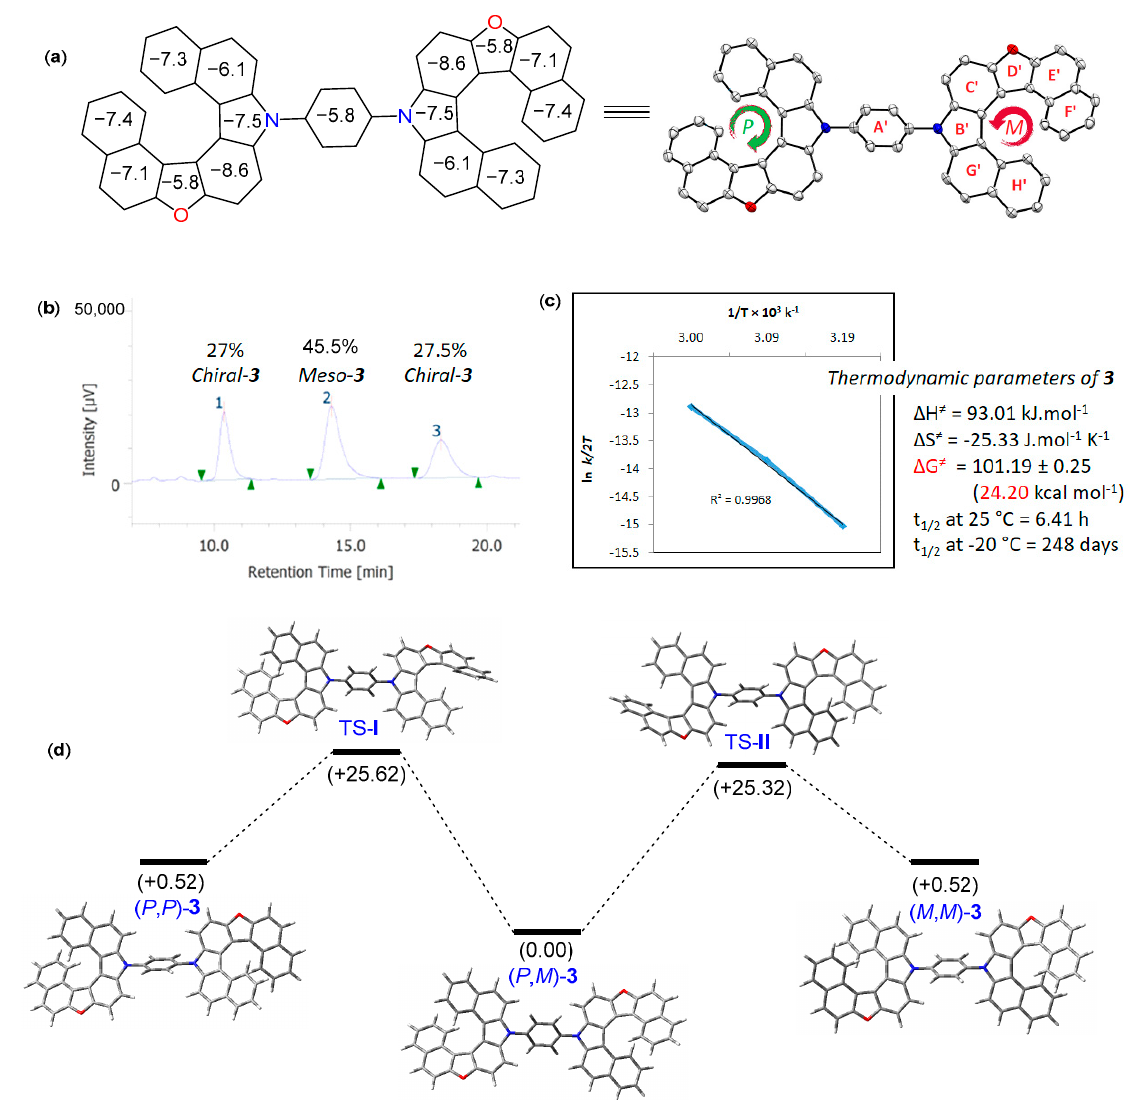
Figure 3. ( a ) NICS (0) values of ( P , M ) ‐ 3 calculated at the MN15/6 ‐ 311G+(2d,p) level; ( b ) HPLC chromatogram determined by (Daicel Chiralpak IA, n ‐ hexane/ i ‐ PrOH = 20/1, flow rate 1.0 mL/min, T = 25 ºC, 240 nm): t 1 = 10.36 min, t 2 = 14.30 min, and t 3 = 18.32 min; ( c ) Eyring plot of compound 3 epimerization and thermodynamic parameters; ( d ) Epimerization process from ( P , M ) ‐ 3 isomer to ( M , M ) ‐ 3 and ( P , P ) ‐ 3 isomers. The relative Gibbs free energies are calculated in (kcal mol − 1 ) at the MN15/6 ‐ 311G(d,p) level.